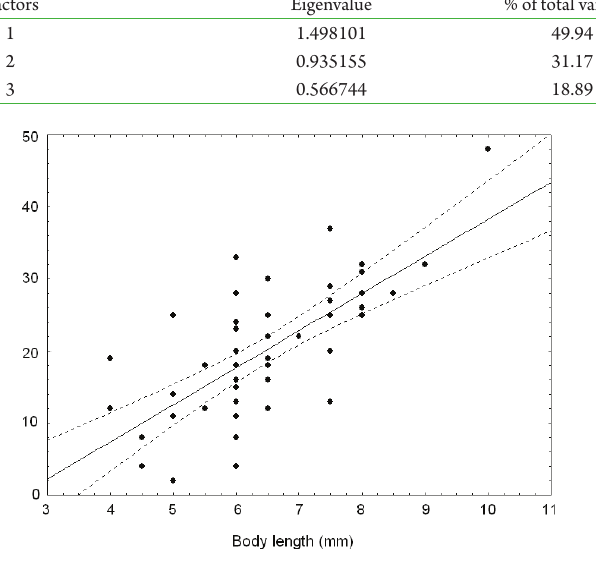
Table 7. Eigenvalues of correlation matrix and explained variance obtained from the PCA using the reproductive parameters as variables and 39 amphipod species listed in supplementary material, from which the three parameters were obtained.